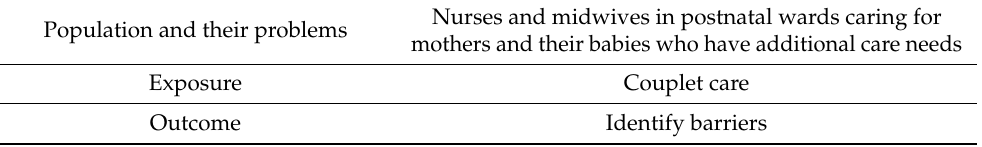
Table 1. PEO framework for search strategy. Nurses and midwives in postnatal wards caring for Population and their problems mothers and their babies who have additional care needs Exposure Couplet care Outcome Identify